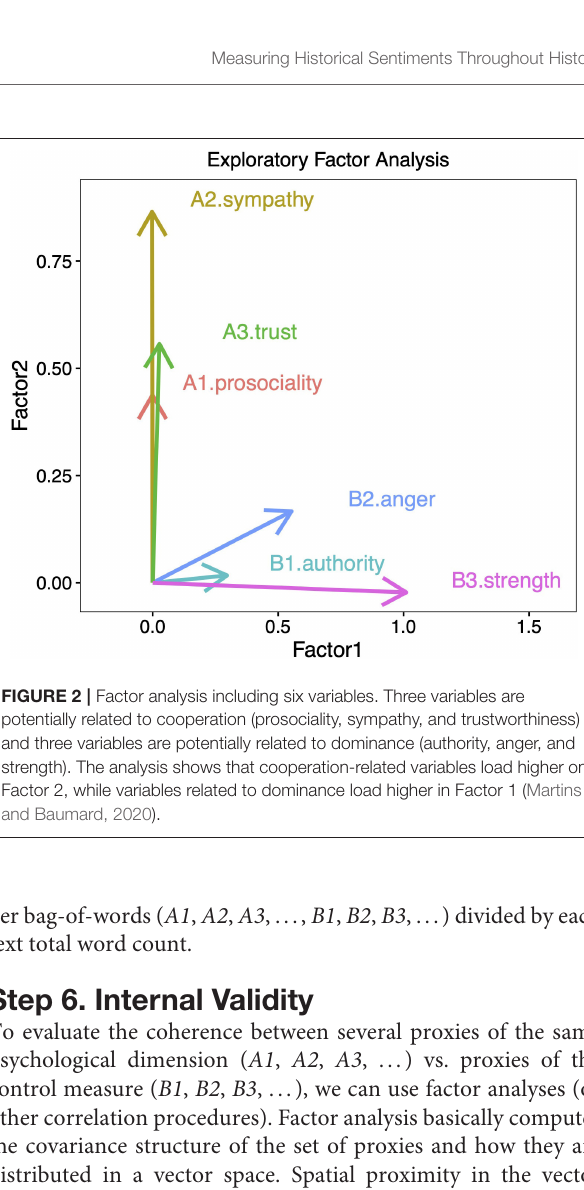
per bag-of-words ( A1 , A2 , A3 , ..., B1 , B2 , B3 , ...) divided by each text total word